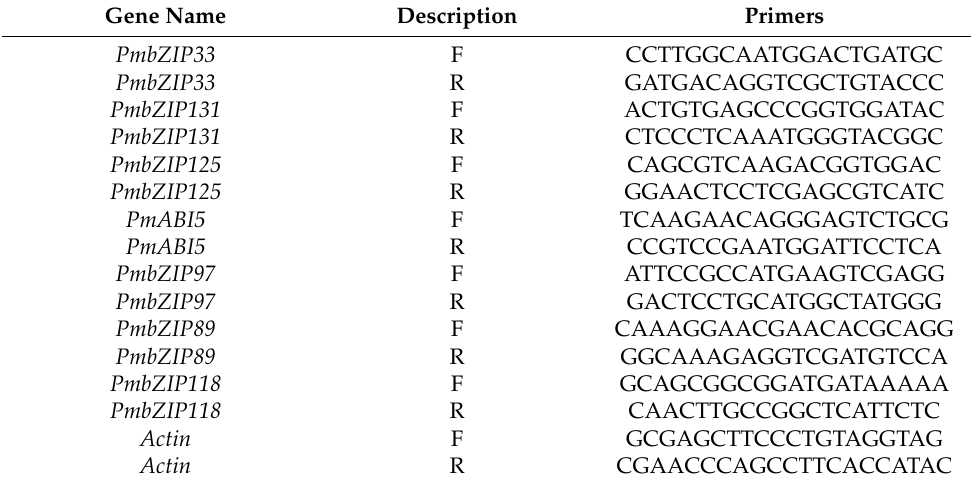
Table 6. Primers of qRT-PCR for validation of the selected